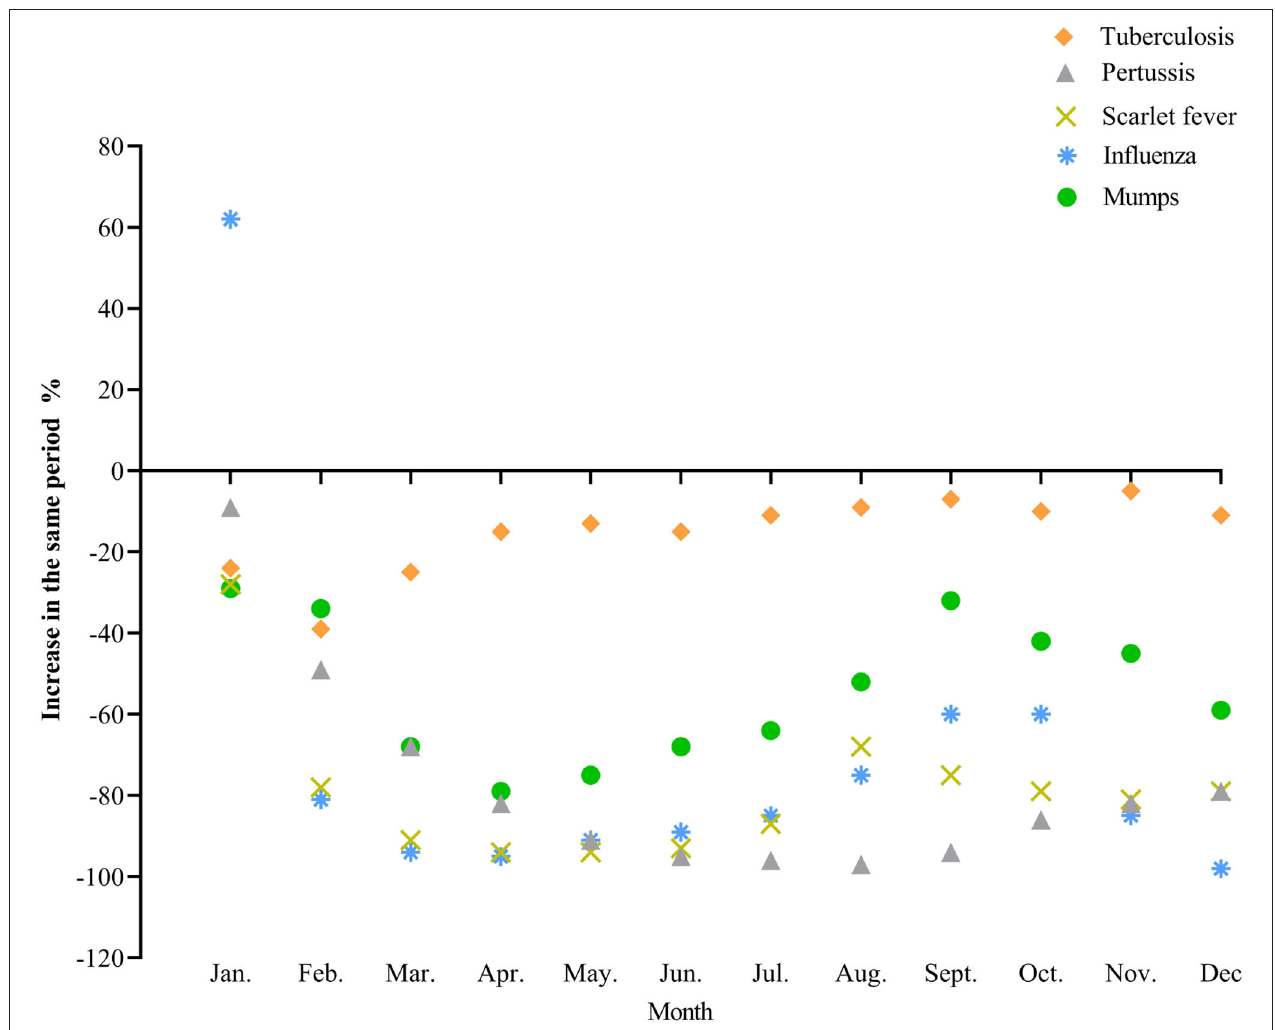
FIGURE 2 | The incidence trend of common respiratory diseases in